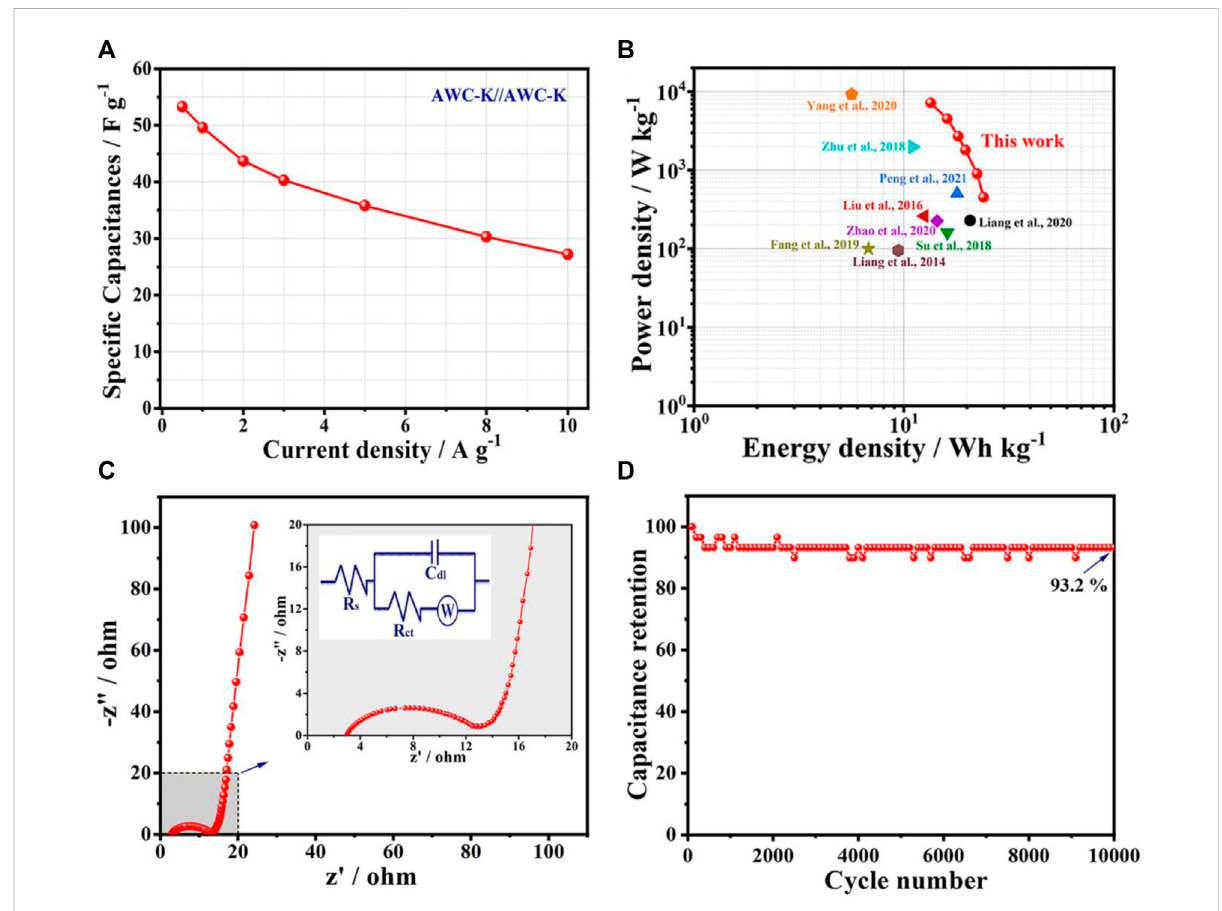
FIGURE 7 (A) Speci fi c capacities of the AWC-K//AWC-K device at various current densities; (B) Ragone plots of the AWC-K//AWC-K device and; (C) NyquistplotsoftheAWC-K//AWC-Kdevice(theinsetoftheequivalentcircuitofEIS); (D) Thecyclingstabilityofthesymmetriccellat3 A g − 1 in0.5 M Na 2 SO 4 electrolyte.